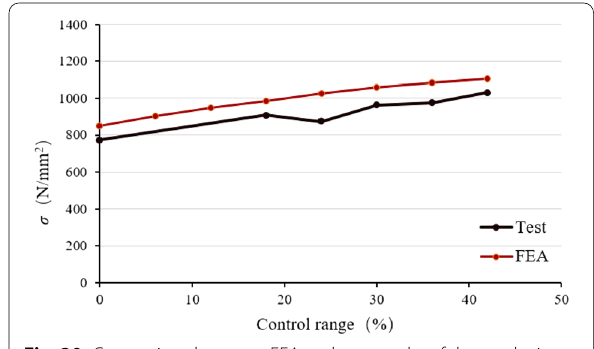
Fig. 20 Comparison between FEA and test results of the steel wire stress